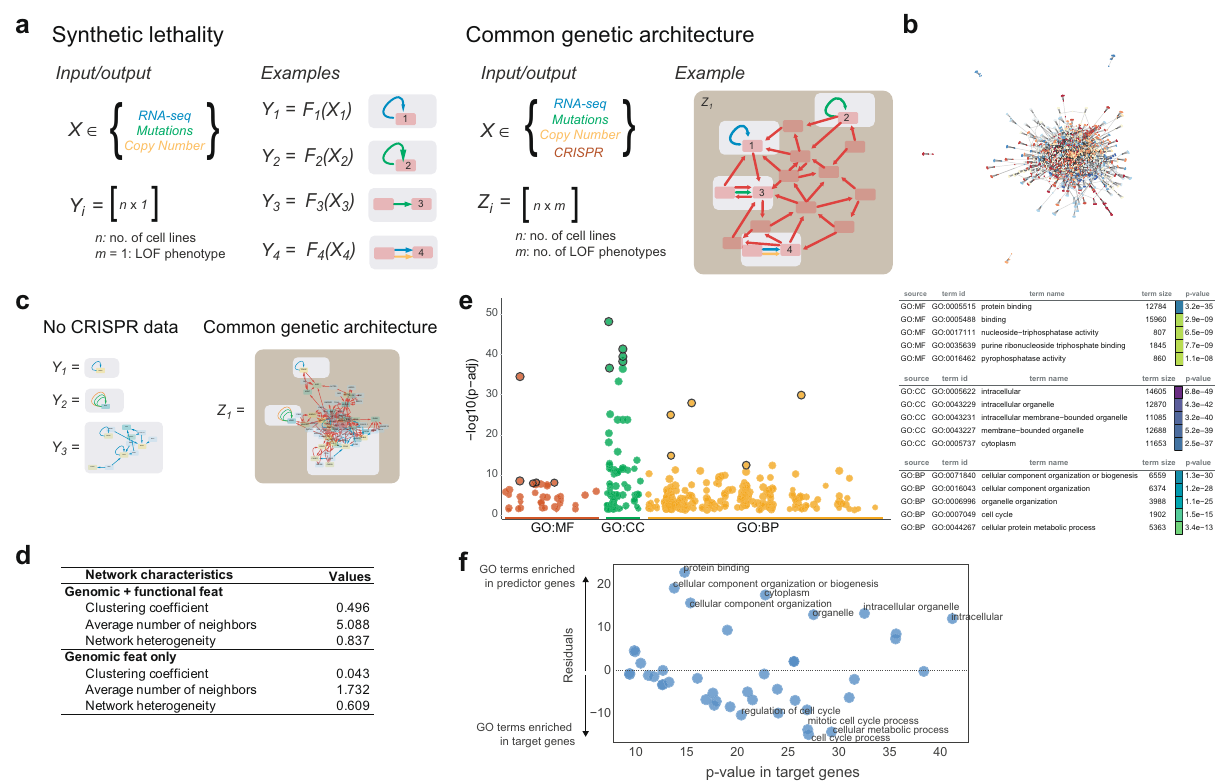
Fig. 3 A common genetic architecture in mammalian cell lines. a Schematic illustrating difference between classic synthetic lethality and our common genetic architecture . Synthetic lethality consists of many individual Y i functions. These functions are cell-type-speci fi c models with single features. Our proposed common genetic architecture is hypothesized to connect these “ private ” functions with shared CERES features. A common genetic architecture has many redundant edges, and more interconnected nodes. More nodes suggest that more cell-type-speci fi c phenotypes are predictable, and more edges suggest redundancy. b A network built from the aggregation of all multivariate models. Genes are represented as nodes and feature-target gene relations as edges. Colors represent distinct subnetwork communities that were identi fi ed by the Louvain method. c Network communities with (right) and without (left) nodes/edges involving functional CRISPR features for a single Louvain community, and a comparison with our hypothesis from ( a ). Edges are colored based upon the data source; and nodes are colored based on the model score (of top ten feature model) of the corresponding gene as target. d To quantitate the visual similarity between our hypothesis in ( a ) and the data in ( c ) across all Louvain communities, we examined the differences in the clustering coef fi cient, the average number of neighbors, and the network heterogeneity. e gpro fi ler2 plots examine the enrichment of functional categories. f Residual plot identi fi es GO terms that are more (residuals of − log10 P values >10) or less (residuals of -log10 P values < − 10) enriched in predictor genes than in target genes. Dots represent shared GO terms among the 100 most signi fi cant terms in target and predictor gpro fi ler2 analysis result. The p- values from gpro fi ler2 for ( e ) and ( f ) are based on hypergeometric tests with multiple testing corrections using the g:SCS method. Source data are provided as a Source Data fi